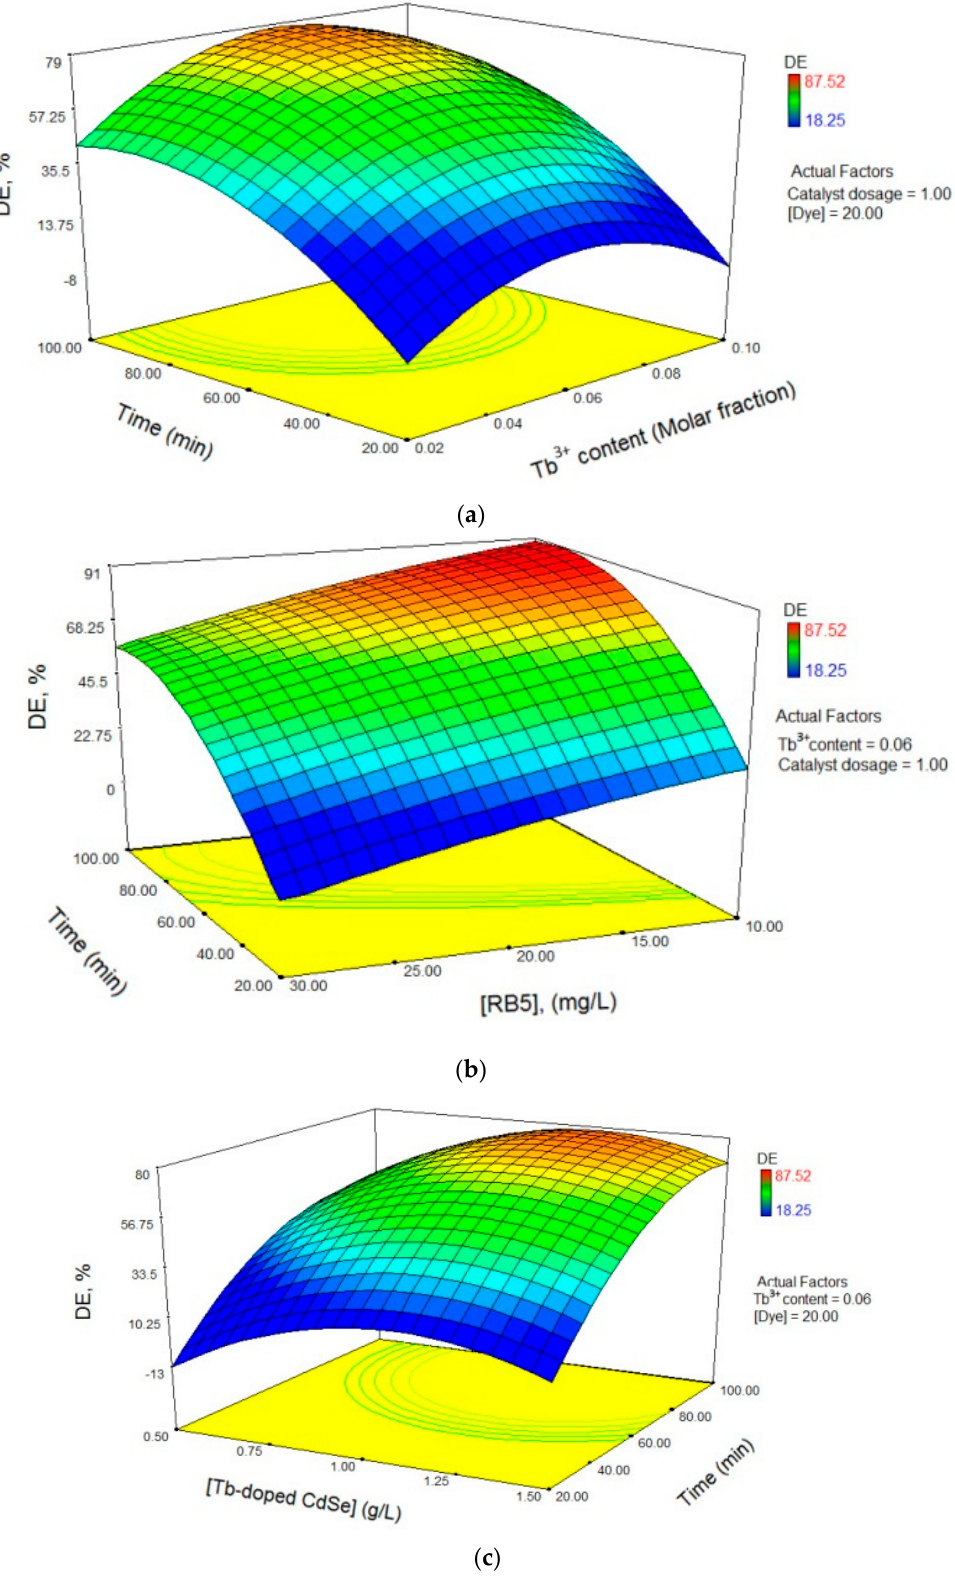
Figure 11. Response surface plots and counter plots of decolorization efficiency as a ( a ) function of Tb 3+ content and contact time, ( b ) initial dye concentration and contact time, and ( c ) catalyst dosage and contact time.